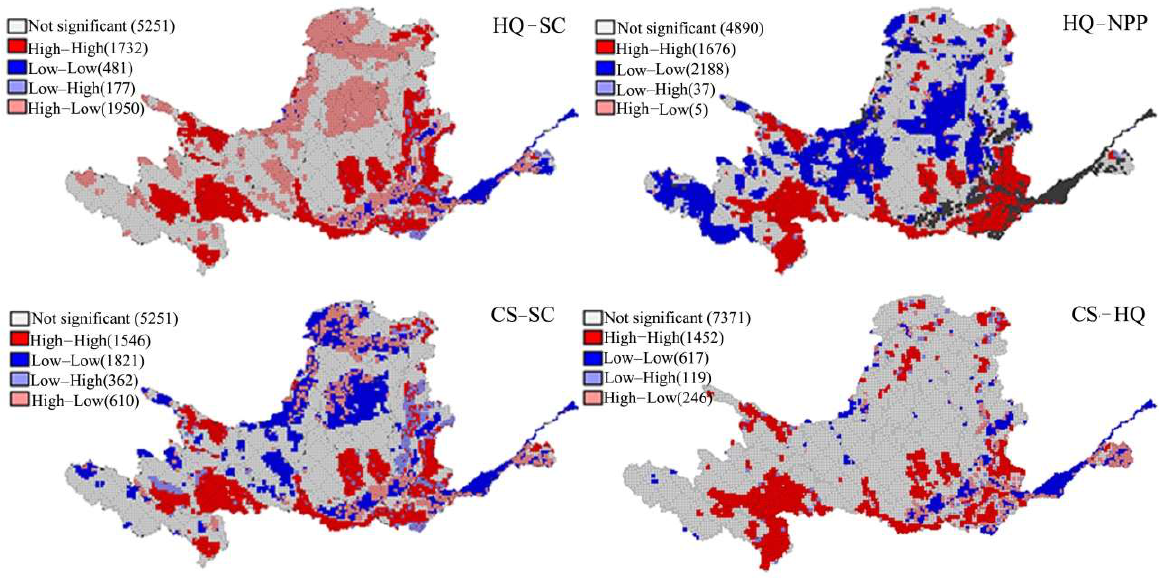
Figure 4. Bivariate spatial correlation analysis of ecosystem service of grassland system. (WY: water yield; CS: Carbon Storage; HQ: Habitat Quality; SC: Soil Conservation).